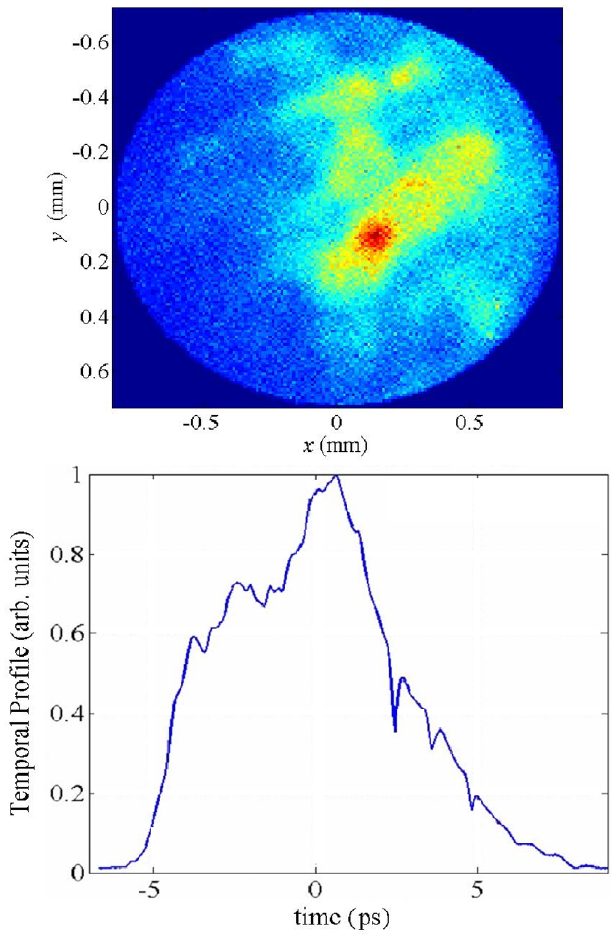
FIG. 32. (Color) Point-to-point image of cathode (top) at low charge ( (cid:8) 20 pC ) observed on the second YAG screen of the gun-to-linac section, and the cross-correlator temporal profile (bottom) with bunch head at right.